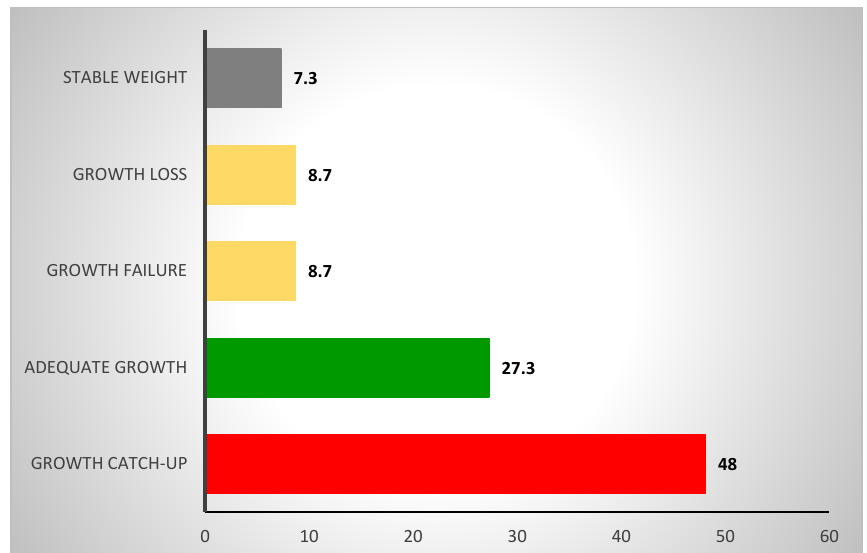
Figure 3. Weight growth of the children at the end of the LNR sessions ( n = 289). Appropriate weight gain: ≥400 g; stable weight: weight gain equal to their weight at admission; adequate growth: weight gain ≥200 and ≤400 g; weight loss: weight gain ˂ admission weight; growth failure: ˂ 200 g).